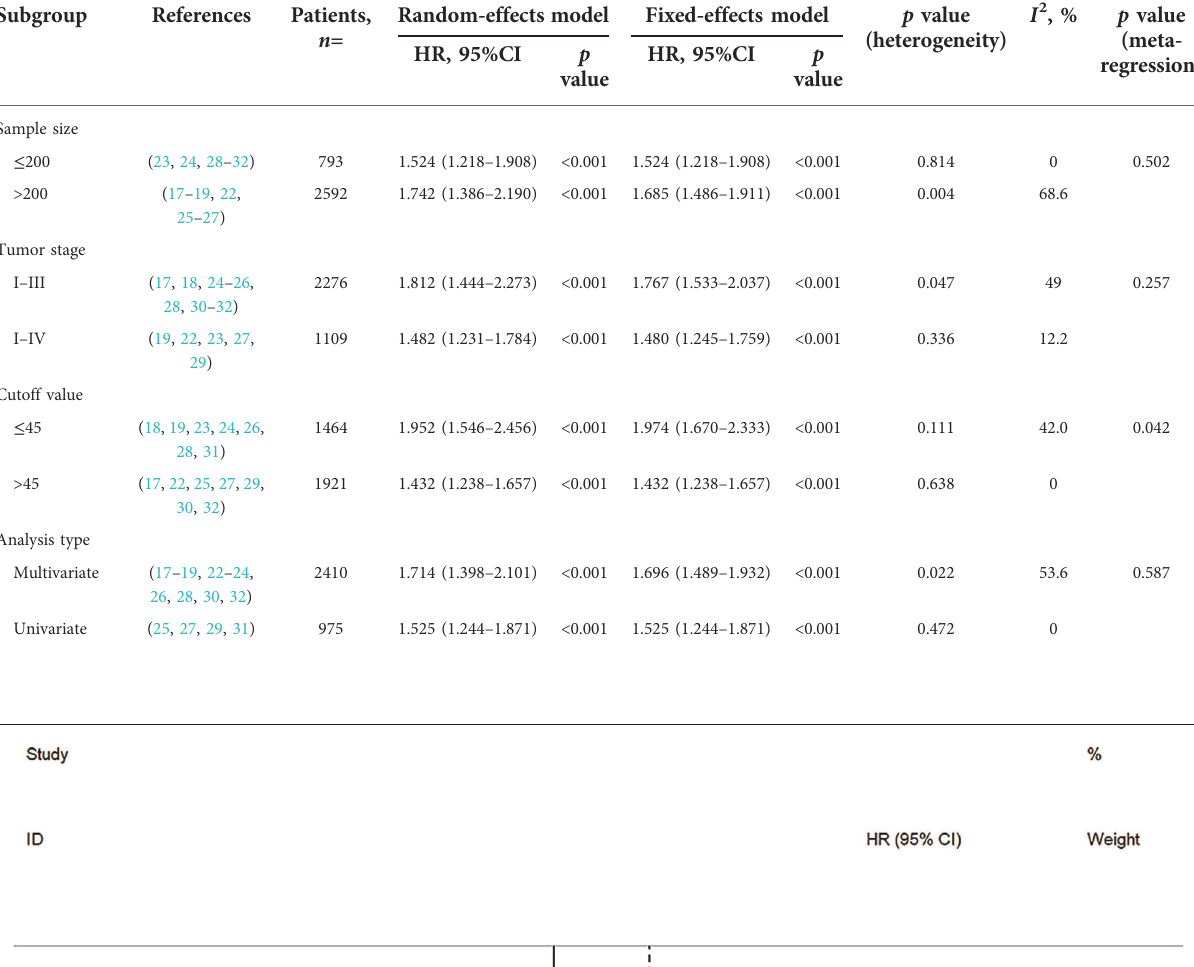
TABLE 2 The results of subgroup analyses and meta-regression analyses.